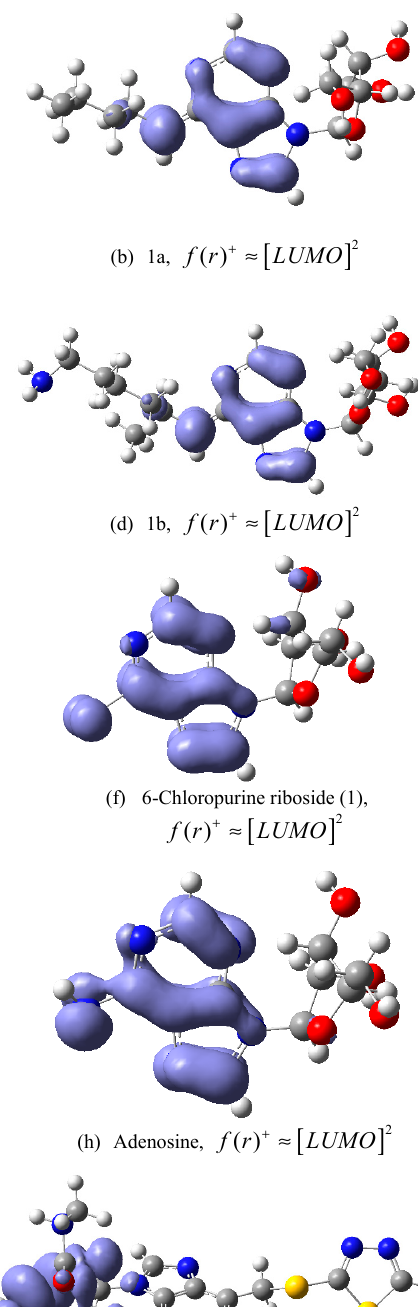
Figure 3. Local reactivity descriptors (Fukui functions) f ( r ) [ ] 2 LUMO + ≈ for some selected compounds: ( a, b ) 1a , ( c, d ) 1b , ( e, f ) 6-chloropurine riboside ( 1 ), ( g, h ) adenosine, and ( i, j ) compound 4 .